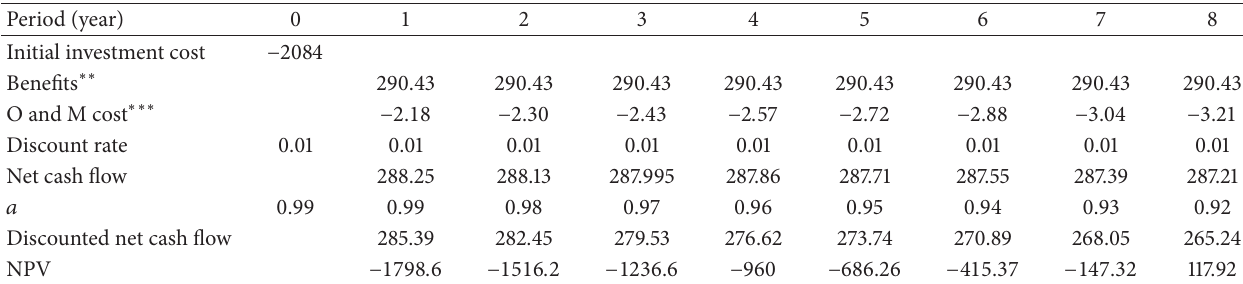
Table 7: Economical analysis of LCPV system (having a lifetime of 25 years [24]).